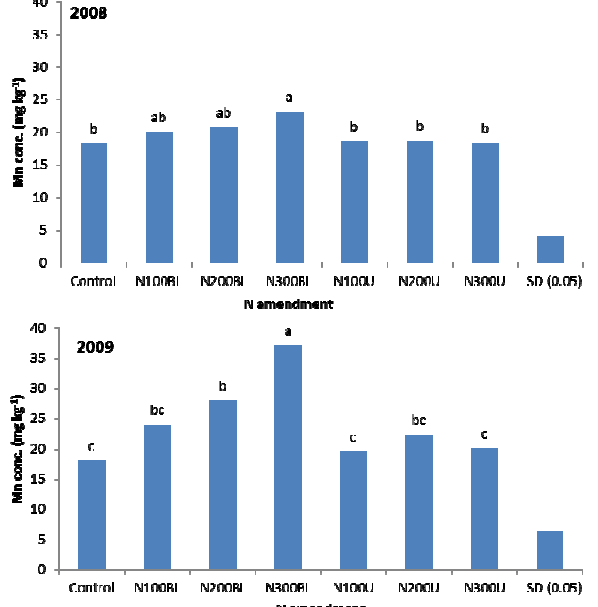
Fig. 3. The effects of N source and rate on Mn concentration of silage corn in 2008 and 2009. Control: without chemical fertilizer and broiler litter; N , N , and N : 100, 200 100U 200U 300U and 300 kg ha -1 of N as urea fertilizer, respectively; N , 100BL Fig. 5. The effects of N source and rate on Cu concentration of N , and N : 100, 200 and 300 kg ha -1 of N as broiler 200BL 300BL silage corn. Means with the different letters show significant litter, respectively. Means with the different letters show difference (LSD, P≤0.05). See Fig. 2 for significant difference (LSD, P ≤ 0.05)